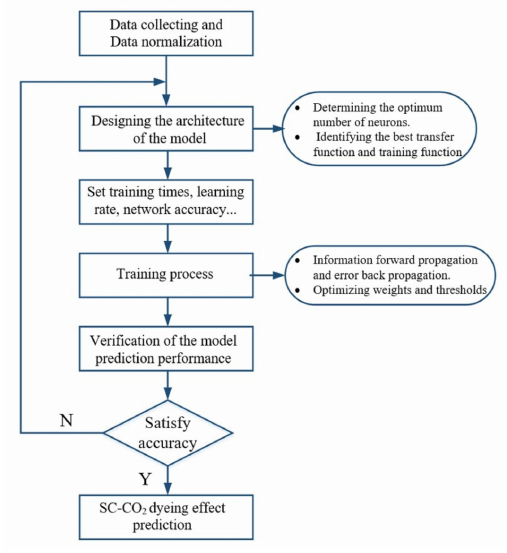
Figure 4. Preparation steps of the BPNN